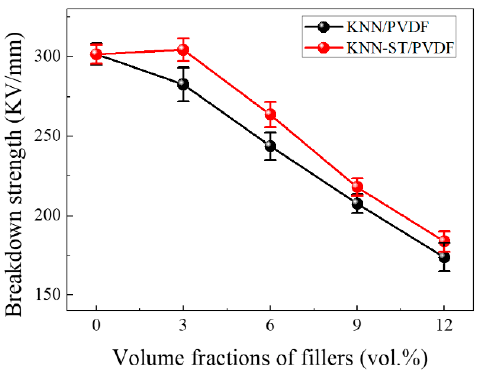
Figure 6. The Breakdown strength of KNN/PVDF and KNN-ST/PVDF composites films.